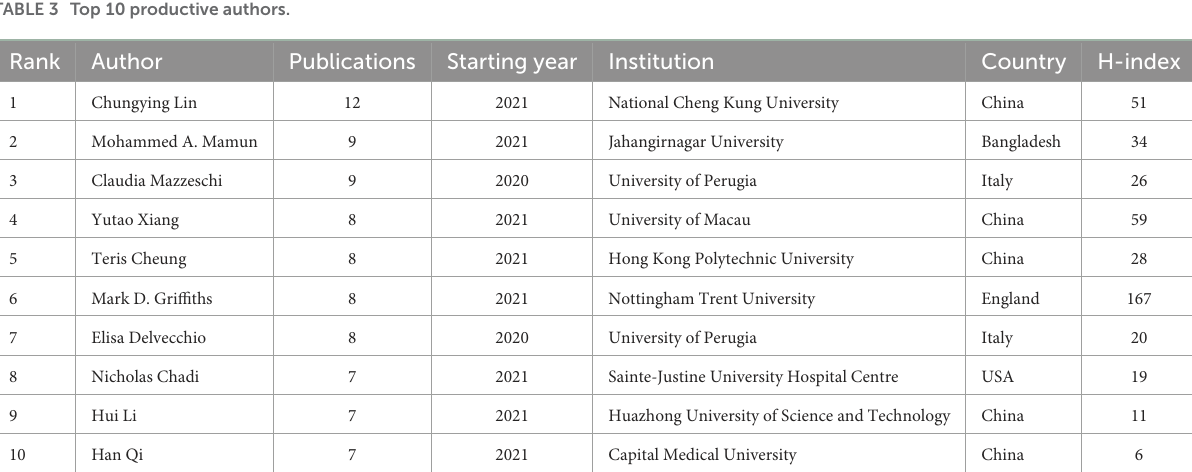
TABLE 3 Top 10 productive